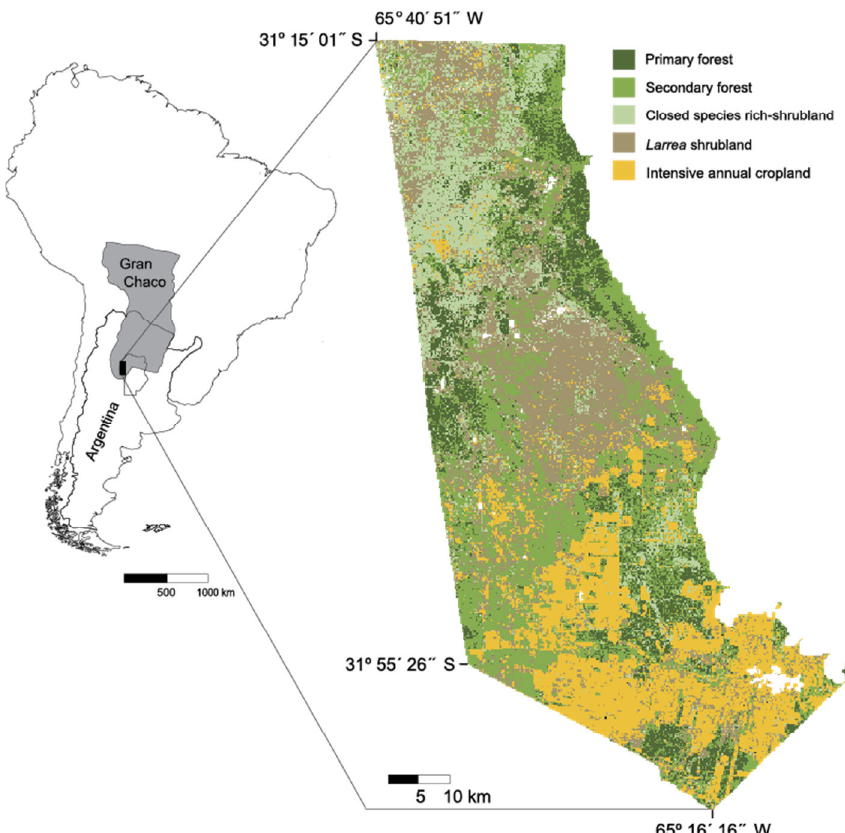
Figure 1. Location of the study area in Argentina and South America, and distribution of different ecosystem types within it. The land cover map was made using Landsat images for 2004 (TM, 30 x 30 m resolution) over the study area (c. 240.000 ha) and is based on Hoyos et al. (2013). The names of the ecosystem types follow Conti & Díaz (2013). Percentage of the study area occupied by each ecosystem type are: 12.93% for primary forest, 27.22% for secondary forest, 14.62% for closed species-rich shrubland, 23,84% for Larrea shrubland, 21.14% for intensive annual cropland and less than 1% for logged pastureland. The latter is not shown because the size of the patches is below the resolution of the map. Detailed descriptions of each ecosystem type are provided in Conti & Díaz (2013) and summarized in Figure 2. The percentage of primary forest is unusually high for the wider region, and is associated to the existence to the Chancaní Provincial Nature